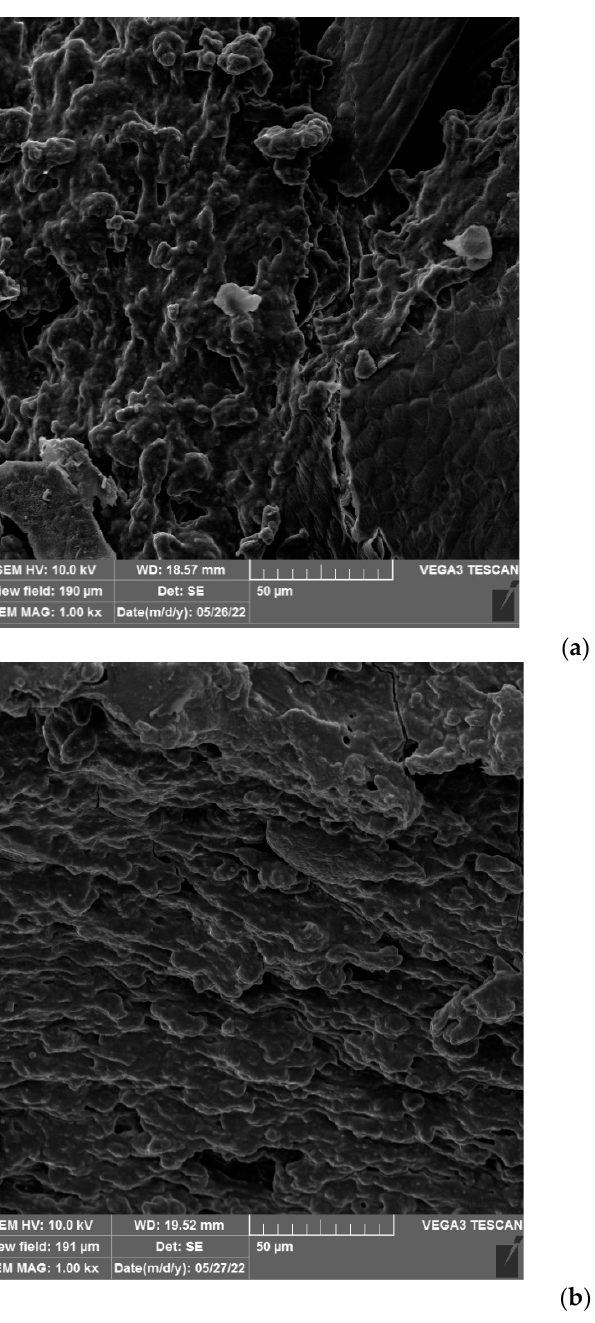
Figure 2. ( a ) The surface of the snack S1; ( b ) the cross-section of the snack S1.